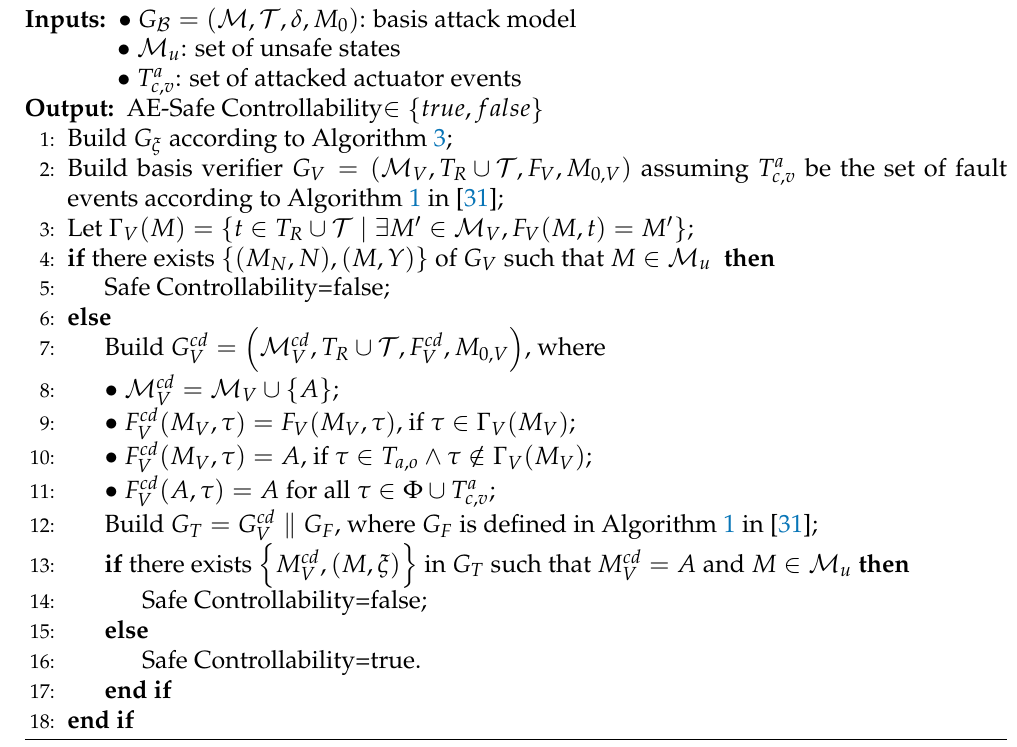
Algorithm 5 AE-safe controllability test using basis